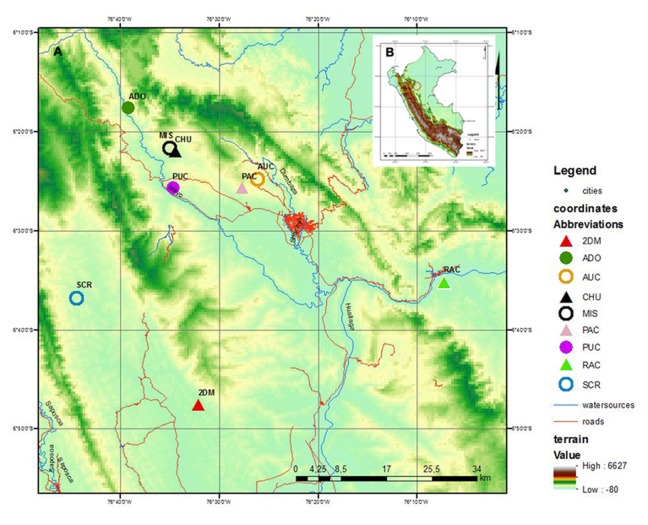
Maps showing sampling locations of P. volubilis in the Peruvian Amazon.Inset: Map A shows the San Martin region with the positions of P. volubilis sampling in detail. Map B shows the localization of San Martin within the whole of Peru.